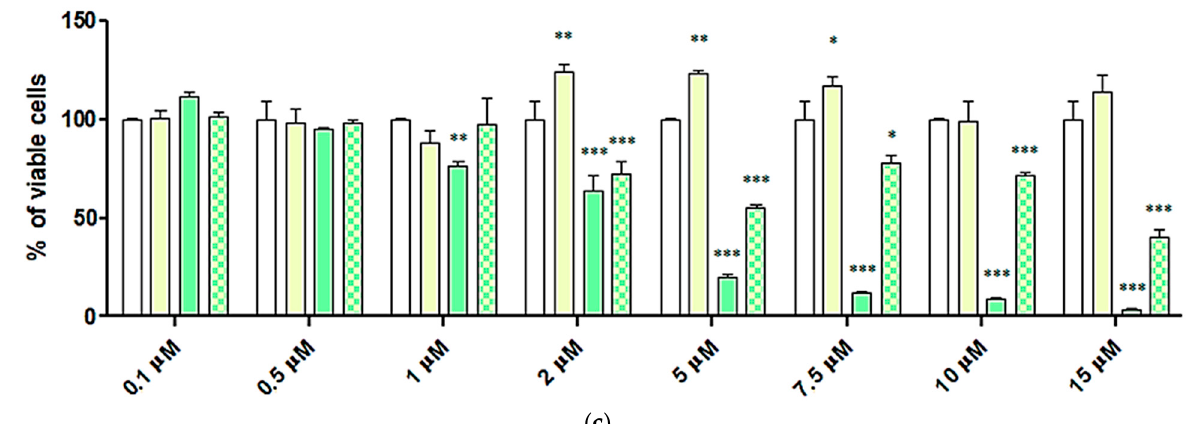
Figure 10. Dose- and time-dependent cytotoxicity activity of P5, 4-HPR, and 4-HPR-P5 NPs at 24 h ( a ), 48 h ( b ), and 72 h ( c ) in SH-SY5Y cells. Concentration values reported on the x-axis refer to 4-HPR, while the concentrations used for P5 and 4-HPR-P5 NPs can be derived from Table 2. White columns: control; yellow columns: P5; green columns: free 4-HPR; and checkered columns: 4-HPR-P5 NPs. Significance refers to control ( p > 0.05 ns; p < 0.05 *; p < 0.01 **; p < 0.001 ***).